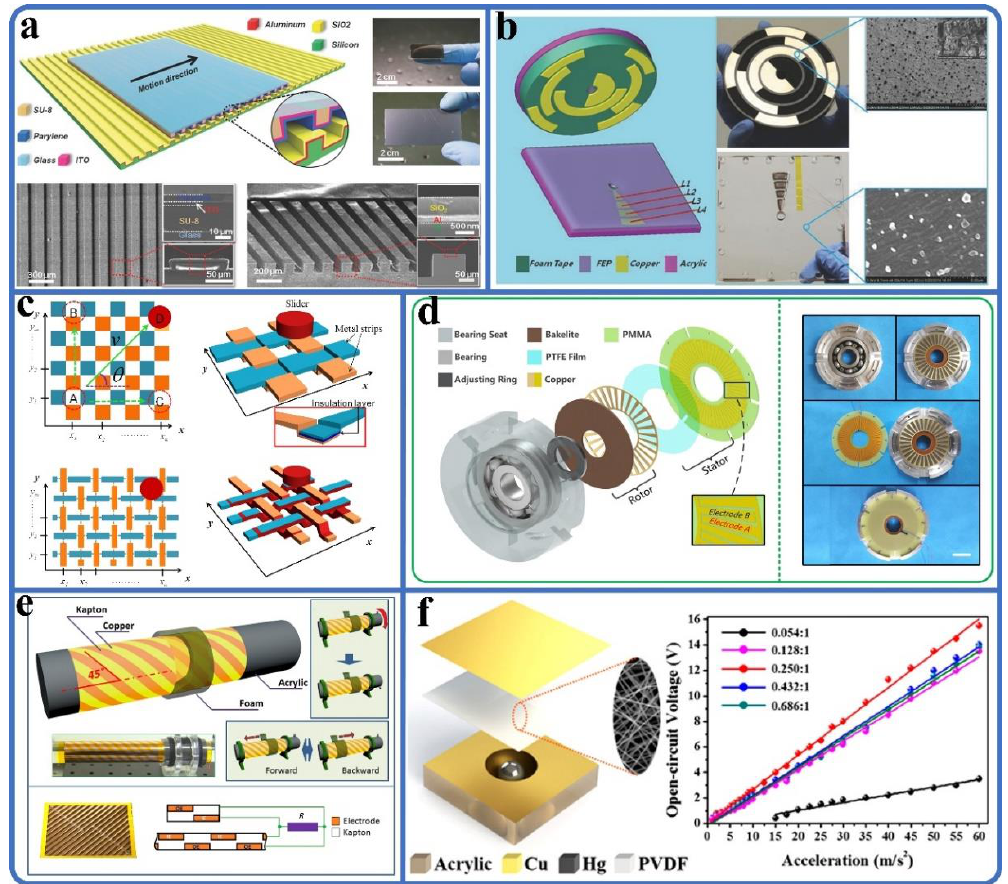
Figure 7. Mechanical motion sensors based on TENG for different motion modes. ( a ) Linear velocity